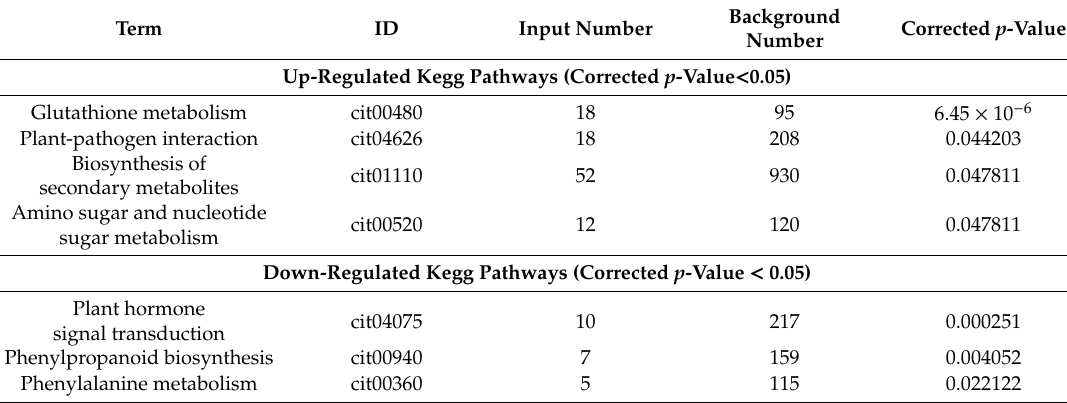
Table 4. KEGG pathway enrichment of DEGs from CEVd-infected citron plants.